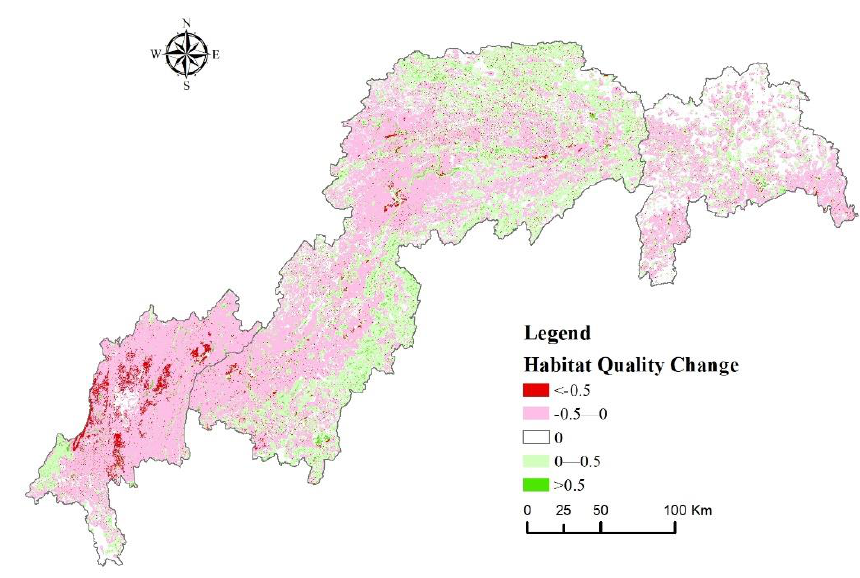
Figure 7. Spatial distribution of habitat quality change difference from 2000 to 2020.